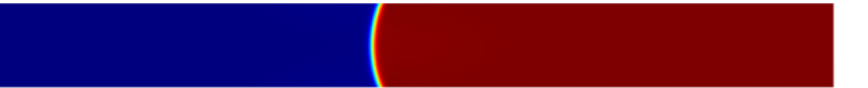
Figure 4. Simulation result of the phase-field method (blue area represents water and red area represents